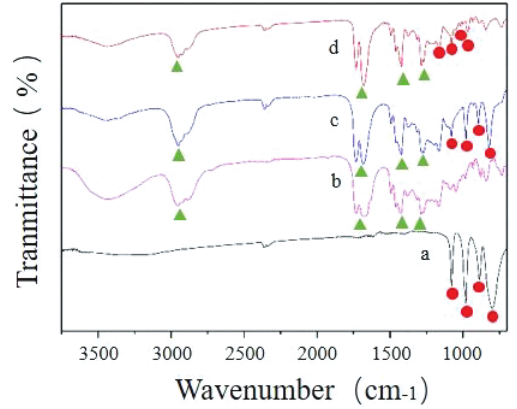
Figure 2: FT-IR spectra of: a – PWA particles, b – P (1VPco1MA), c – composite films PWA/P (1VPco1MA) without irradiation, d – composite films PWA/P(1VPco1MA) after irradiation with UV